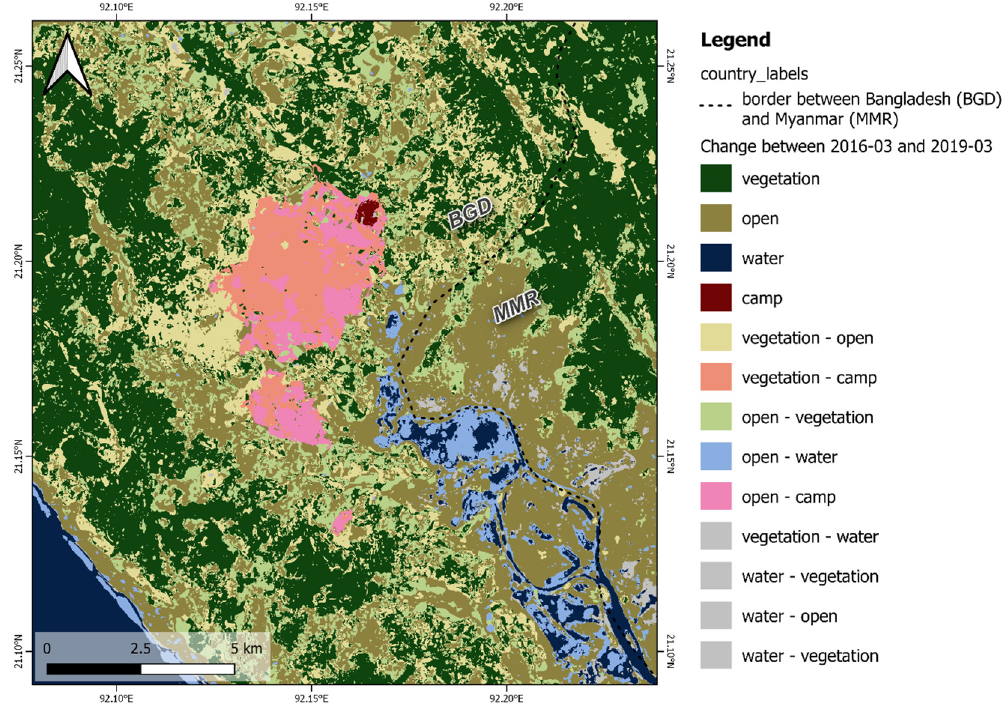
Figure 6. Absolute change in land cover between March 2016 and March 2019, as detected in this study. Note: The dark tones indicate constant land cover, while the bright tones indicate transitions between two classes. For the sake of readability, gray colors were assigned to transitions related to water.